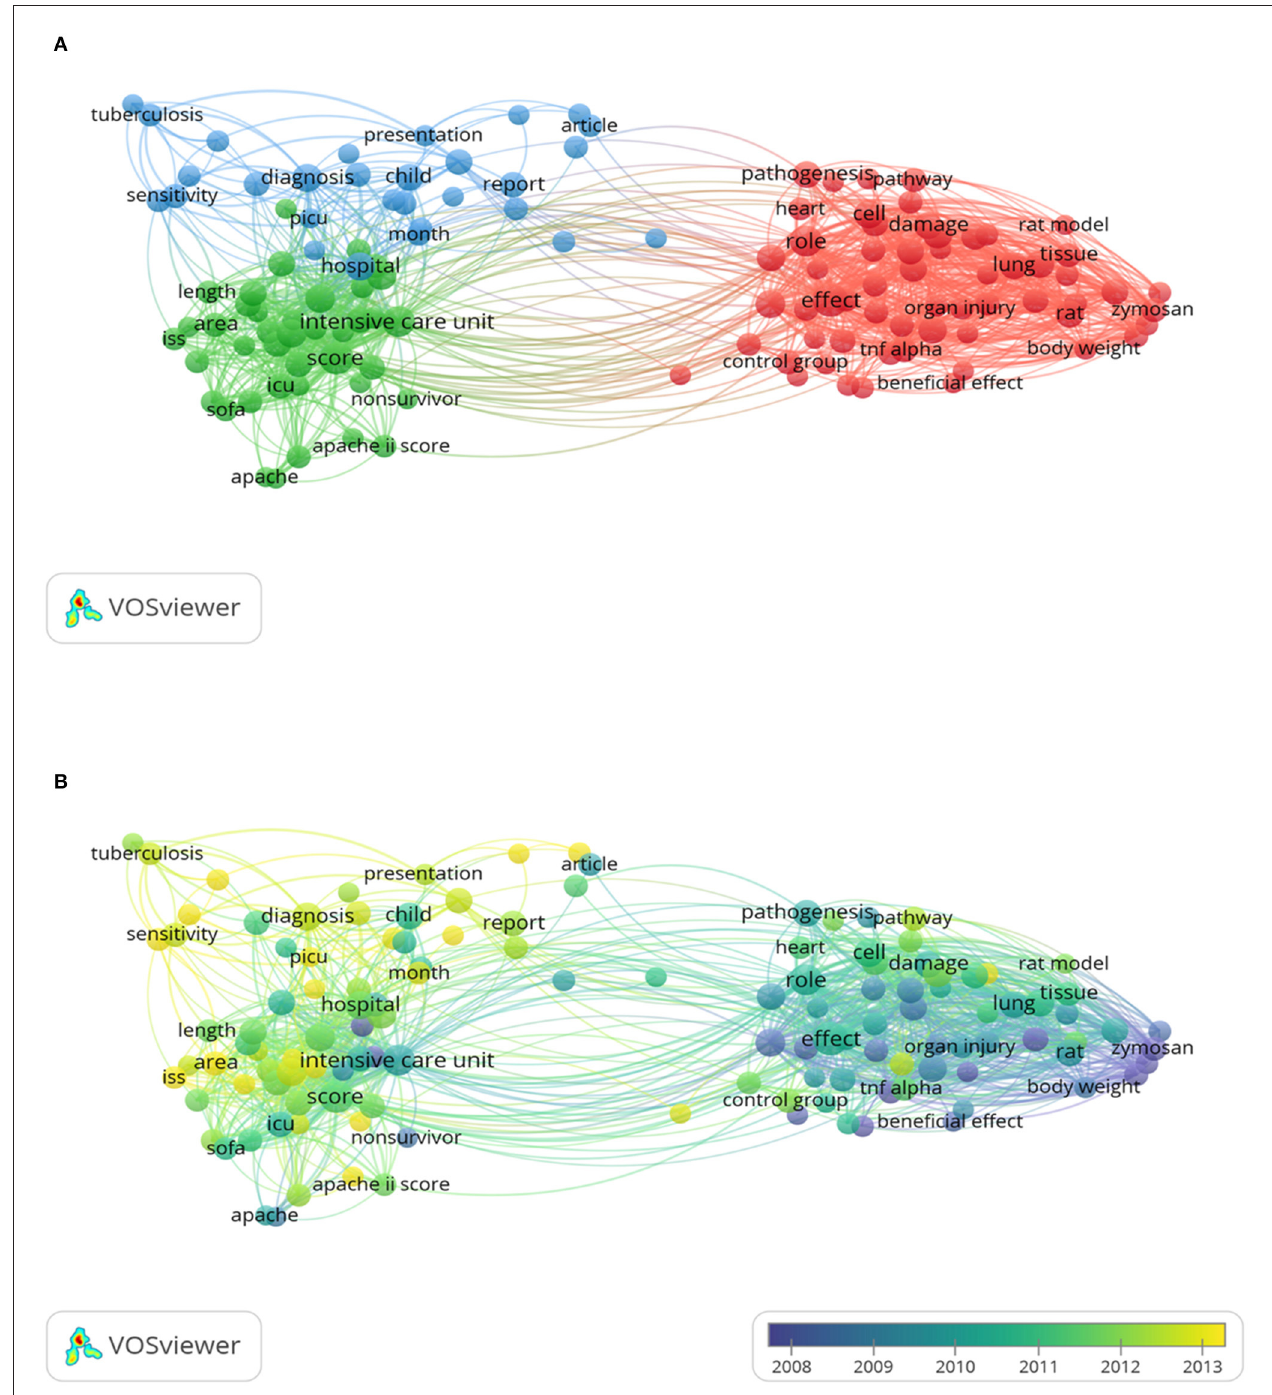
FIGURE 8 | The analysis of keywords in publications of MODS. (A) Mapping of the keywords in the area of MODS. The words were divided into 3 cluster in accordance with different colors generated by default: mechanism research (right in red), clinical research (left in green) and diagnostics and laboratory research (up in blue). The circle with a large size represented the keywords that appeared at a high frequency; (B) Distribution of keywords was presented according to the appearance for the average time. The blue color represented early appearance and yellow color recent appearance. Two keywords co-occurred if they both occurred on the same line in the corpus file. The smaller the distance between two keywords, the larger the number of co-occurrences of the keywords.